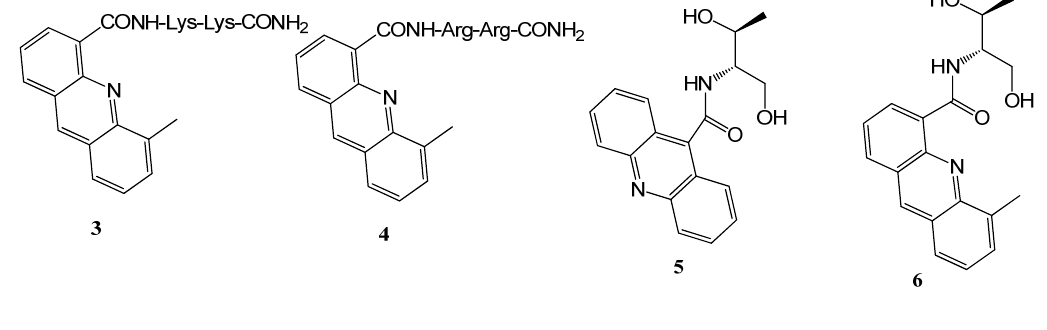
Figure 2. The acridine and 5-methylacridine derivatives synthesized in this